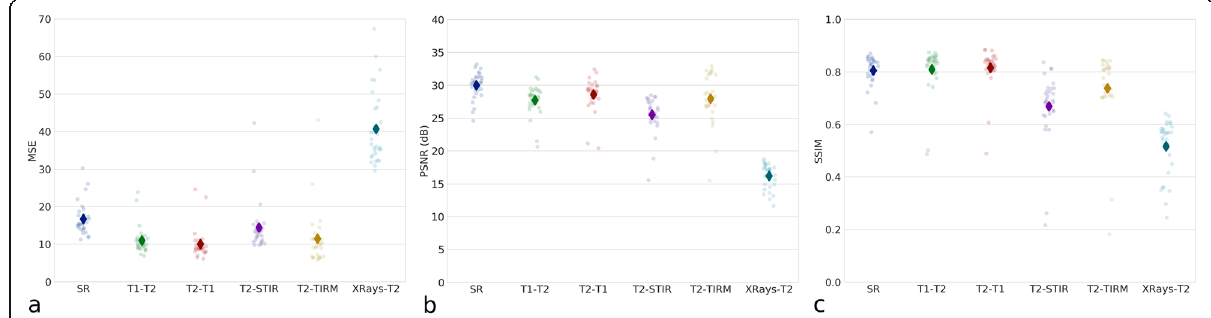
Fig. 7 Quantitative evaluation of the quality, based on different metrics (MSE ( a ), PSNR ( b ) and SSIM ( c )) of the various image-to-image translation tasks: super-resolution (SR), T1W to T2W MRI images (T1-T2), T2W to T1W images (T2-T1), T2W to STIR images (T2-STIR), T2W to TIRM images (T2- TIRM), sagittal standing x-ray projections to T2W images